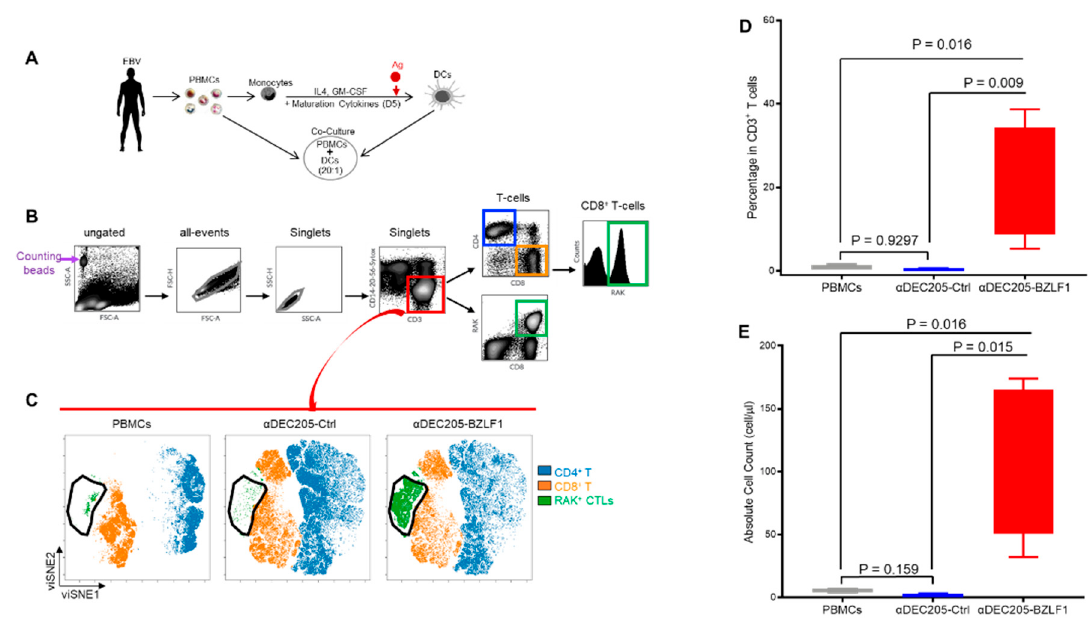
Figure 1. In vitro evaluation of BZLF1 immunogen through DC: PBMC CoCx, followed by HLA-pentamer loaded with BZLF1 RAK peptide and flow cytometry; ( A ) Schematic of the CoCx experiments; ( B ) Gating scheme for pentamer flow data; ( C ) viSNE immunome maps that show distinct clusters representing different immune cell types; ( D ) Frequency of RAK+ T-cells from PBMCs, α DEC205-Ctrl CoCx, and α DEC205-BZLF CoCx across 4 HLA-B8 donors; ( E ) Absolute count of RAK+ T-cells from PBMCs, α DEC205-Ctrl CoCx, and α DEC205-BZLF CoCx across 4 HLA-B8 donors.